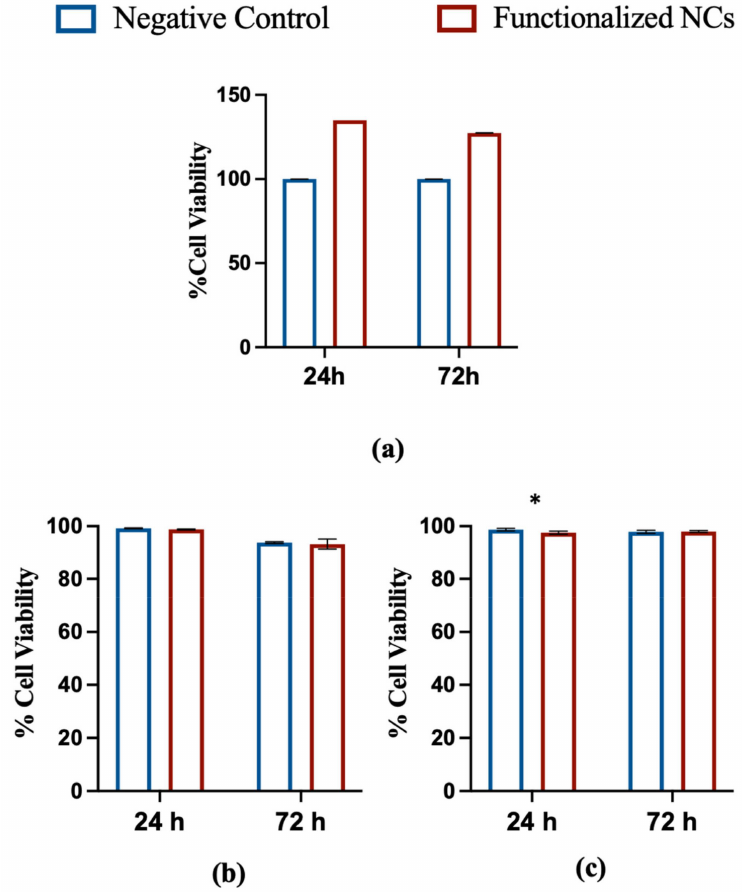
Figure 4. In vitro cytotoxicity tests. ( a ) Cytotoxicity MTT assay of functionalized NCs after 24- and 72-h incubation with NIH3T3 cells. A comparison with negative control is shown; ( b ) Propidium Iodide Flow Cytometry assay of functionalized NCs after 24- and 72-h incubation with HeLa cells. A comparison with negative control is shown; ( c ) Propidium Iodide Flow Cytometry assay of functionalized NCs after 24- and 72-h incubation with NIH3T3 cells. A comparison with negative control is shown (* p < 0,05; t -test; mean ± SD; n =